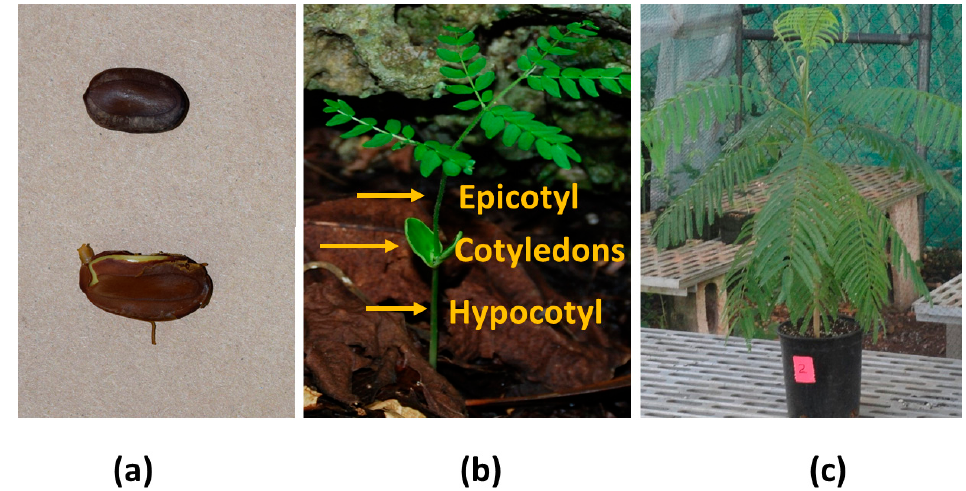
Figure 1. The general appearance of a Serianthes nelsonii seedling. ( a ) Non-scarified seed (top) and scarified + imbibed seed (bottom). ( b ) At the end of the germination growth phase when a quiescent period occurs. ( c ) General appearance at about 30 cm height.